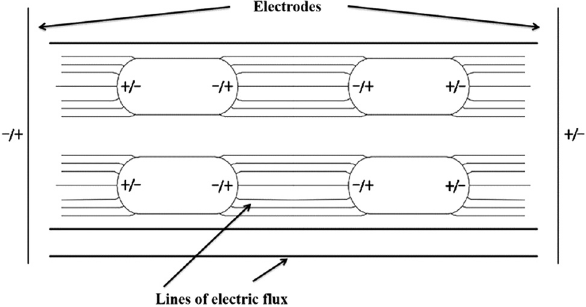
Figure 10: Schematic illustration of the interaction between aligned and polarized cylindrical particles in an electric fi eld [ 102 ]